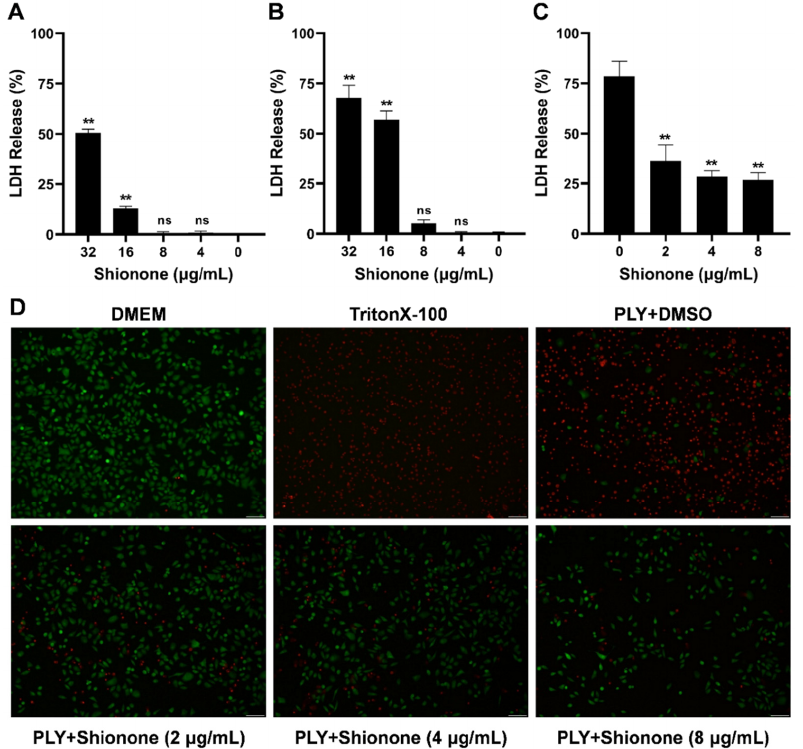
Figure 2. Shionone has no cytotoxicity on mammalian cells and alleviates PLY-mediated cell injury at less than 8 µ g/mL. ( A , B ) Cytotoxicity of different concentrations of shionone (4–32 µ g/mL) in A549 cell lines and J774 cell lines. ( C ) LDH release in A549 cells induced by PLY with or without shionone treatment. ( D ) Visualization of the protective effect of shionone on A549 cells stained with the LIVE/DEADTM Viability/Cytotoxicity Kit (green for live cells, red for dead cells). The signifi- cance level was expressed as follows: ** p < 0.01; NS, no significant difference. 2.3. Shionone Neutralizes Toxicity by Inhibiting PLY Oligomerization PLY can punch holes in tissue cells to help S. pneumoniae enter the interior of the respiratory tract and cause damage to lung tissue [14]. One of the key steps in pneumoly- sin’s virulent action is oligomerization [15]. Therefore, we examined whether shionone exerts an antitoxic effect by blocking PLY oligomerization. As shown in Figure 3A, oli- gomerization gradually decreased as the concentration of shionone increased. This is sup- ported by the optical density analysis results in Figure 3B. In addition, western blot results showed that shionone hardly inhibited the expression of PLY at less than 4 μ g/mL, as shown in Figure 3C. Molecular docking was performed to search the binding site of shionone on PLY. The binding affinities ( Δ G (kcal/mol)) and inhibitor constant (Ki (nM)) were − 12.9 kcal/moL and 0.342 nM, respectively (Supplementary Table S1). The overview surface modeling between PLY and shionone was shown in Figure 3D, upper panel. In order to show the combination clearly, a protein skeleton model was shown in Figure 3D, bottom panel. The molecular docking results also showed that the potential targets of shionone on PLY were ASP-59, ILE-60, THR-57, PHE-344, and ASN-346 (Figure 3E). ASP- 59, ILE-60, THR-57, and PHE-344 were involved in hydrophobic interactions, whereas ASN-346 was only involved in hydrogen bonds, as shown in Figure 3D,E.